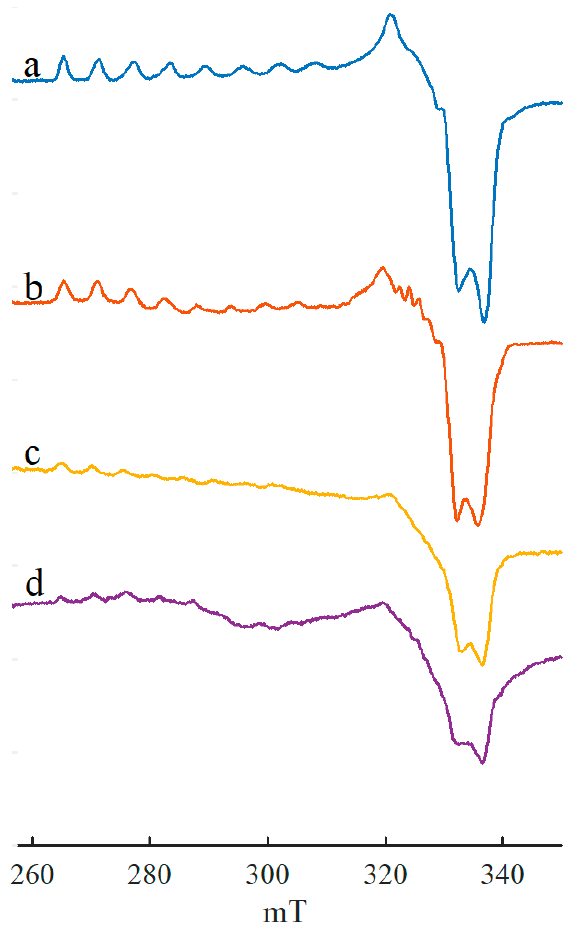
Figure 1. EPR spectra of the Co(acac) 2 –AlEt 3 catalytic system formed in an argon atmosphere, other conditions being equal, in the presence of (a) toluene, (b) mesitelene, (c) p-xylene, (d) durene. Spectrum (a) was taken from [69,77].